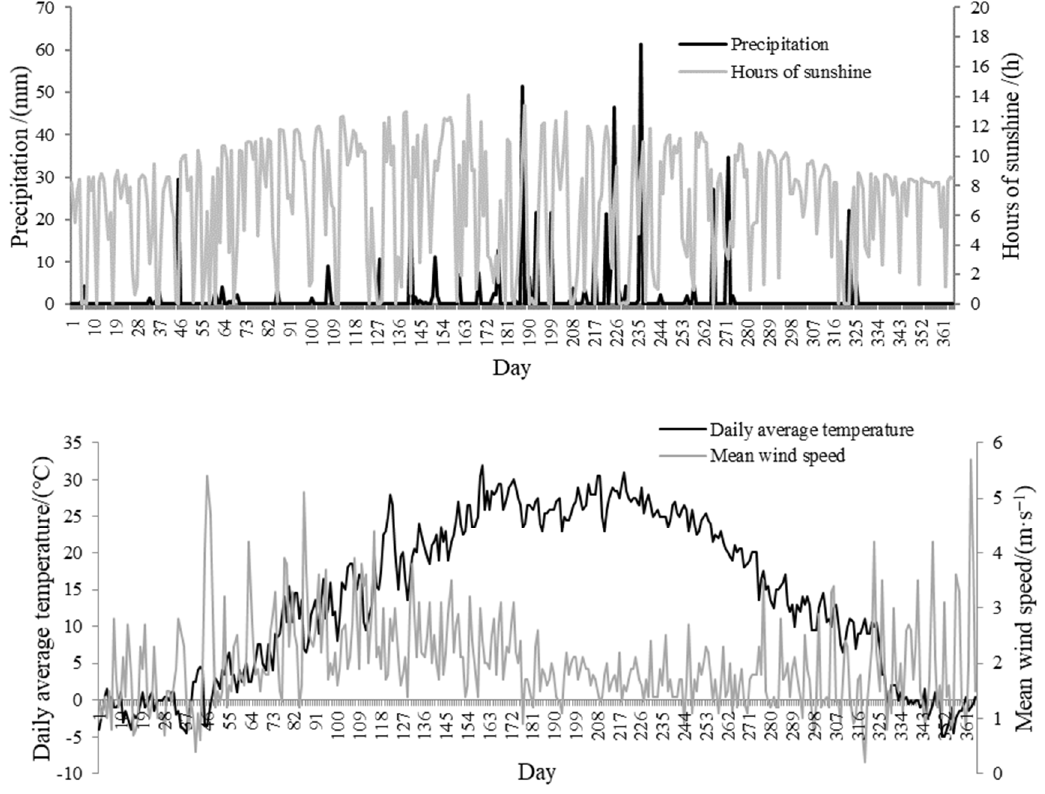
Figure 7. Summary of daily meteorological data. Upper figure: Daily precipitation and daily sunshine hours. Lower figure: Daily average temperature and daily average wind speed.